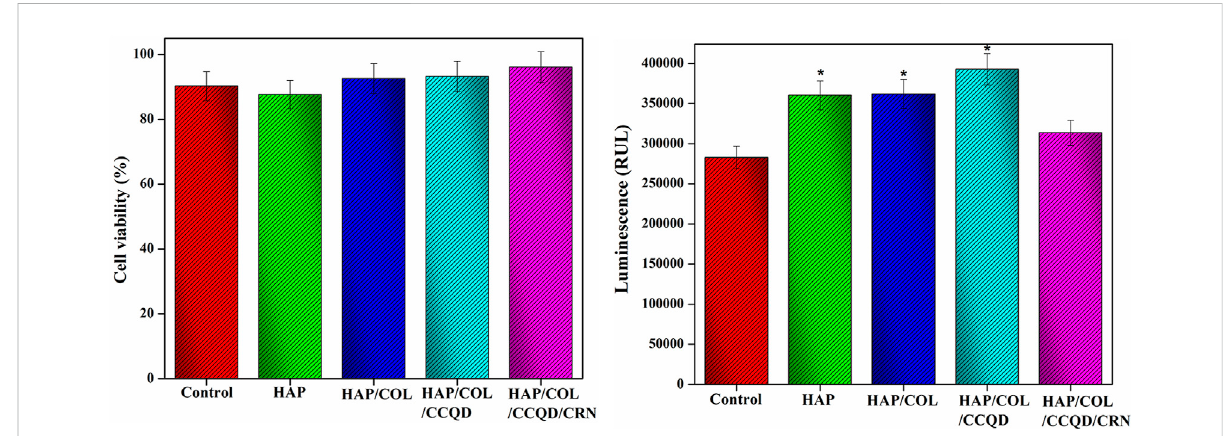
FIGURE 8 (A,B) Viability and cytotoxicity nature of the hBMSCs after treated with (a) pure HAP ceramic (b) HAP/COL composite, (c) HAP/COL/CCQD composite, and (d) HAP/COL/CCQD/CRN composite 14 days of post culturing period. * p < 0.05 comparison of the experimented group with the control cells.